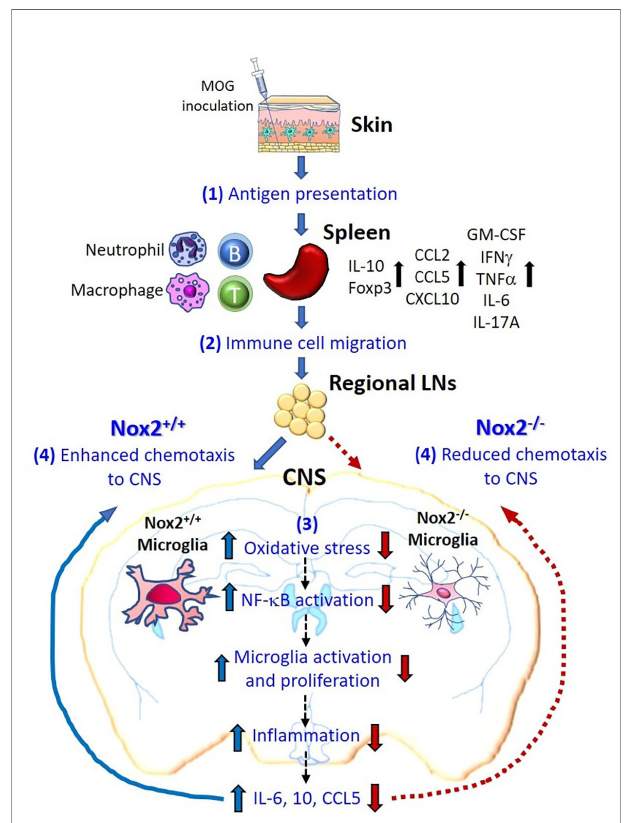
FIGURE 8 | Schematic drawing depicting how microglial Nox2 promotes the pathogenesis of EAE. Our study suggests that Nox2-mediated oxidative stress and chemotaxis in microglia play an important pathophysiological role in EAE-induced neuronal damage as shown in the following stages. (1) Initially, subcutaneous MOG immunization recruits mainly local dendritic cells and, in partly, local macrophages to recognize and uptake the MOG antigen. Thereafter, these cells migrate to nearby inguinal lymph nodes and activate autoreactive T cells through antigen presentation. These primed and activated immune cells further migrate to the spleen where subsequently augment the proliferation of these immune cells as well as the production of multiple cytokines or chemokines. (2) Various immune cells producing different cytokines and chemokines further migrate to the regional lymph nodes near CNS territory. (3) The Nox2-de fi cient microglia fail to produce ROS in response to peripheral immune reaction and in turn reduce the downstream chain reactions, like NF- k B activation, microglia activation and proliferation, in fl ammation, and production of cytokines and chemokines (IL-6, IL-10, CCL5). (4) Summation of all the above responses, Nox2-de fi cient microglia effectively reduce the in fi ltration of pathogenic leukocytes to CNS through reduced chemotaxis ability, which subsequently blocked the immune cells from invading into the CNS in the fi nal step. In contrast, Nox2-competent microglia exhibit an enhanced chemotaxis function. In conclusion, our results demonstrated that the oxidative stress, in fl ammatory reaction, and chemotaxis from Nox2-de fi cient mice are largely reduced in the CNS which greatly halted the neurodegeneration